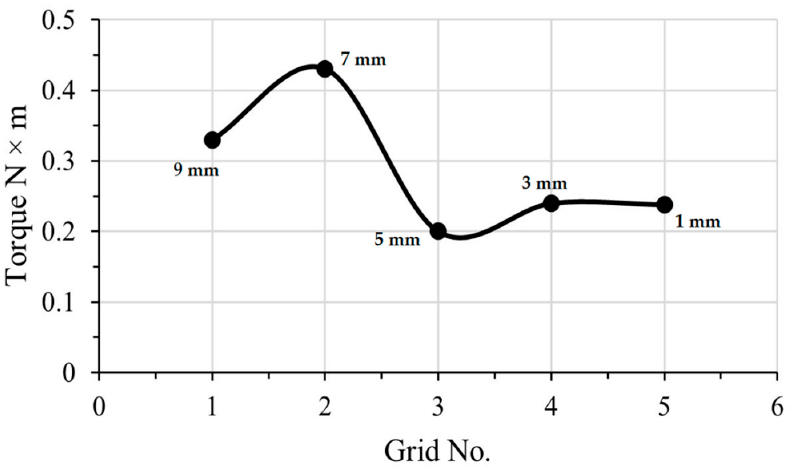
Figure 5. Grid independence of the current study.